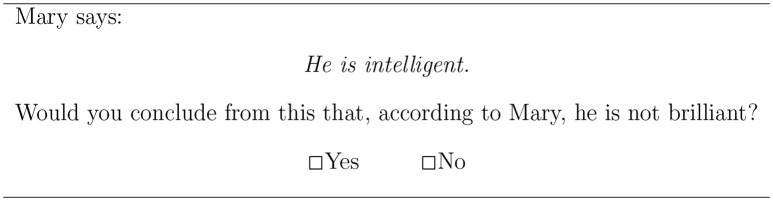
Sample item of the scalar implicature task (based on van Tiel et al., 2016).